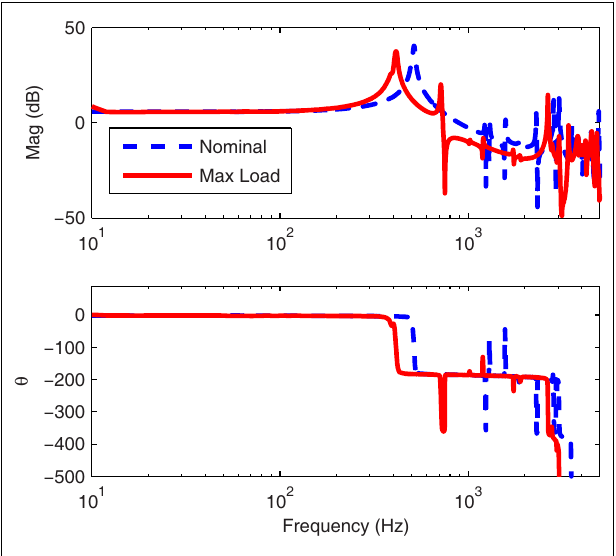
FIGURE 2 | The open-loop frequency response measured from the voltage amplifier input to the sensor output, scaled to (cid:22) m/V . The frequency response of the x -axis with maximum load is compared to the nominal